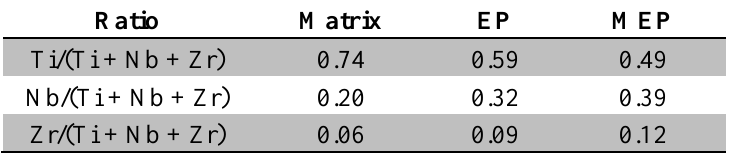
Table 3. Calculated ratios of XPS high resolution spectra of TNZ alloy sample